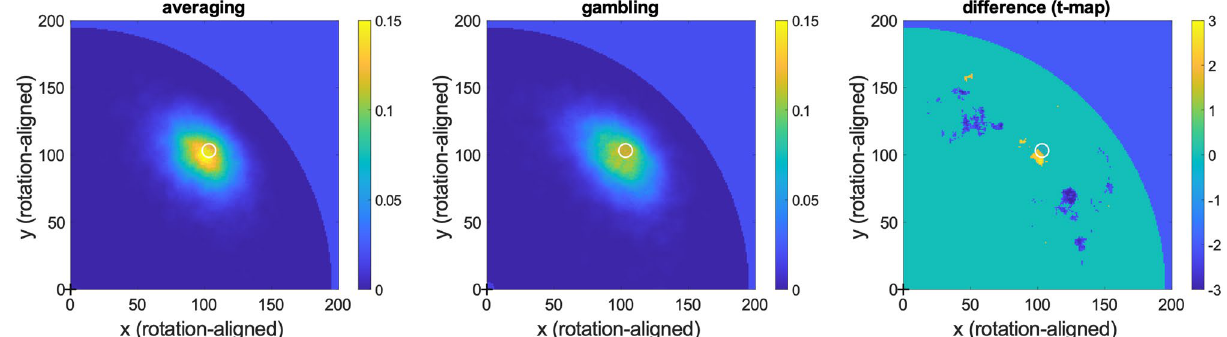
Figure 6. Averaging or gambling—spatial WM precision. Spatial distribution of WM positions reported on WM recall (rotation-aligned as in Fig. 2b), shown separately for the averaging- ( left ) and gambling ( middle ) variants of the intermittent decision task. Right panel shows statistical map of the difference between the two, thresholded at p < 0.05 (two-tailed, uncorrected). White circles indicate true original position (rotation-aligned) of the WM sample. Participants in the averaging condition tended to report more locations near to the target and fewer locations afar from it, compared to the gambling